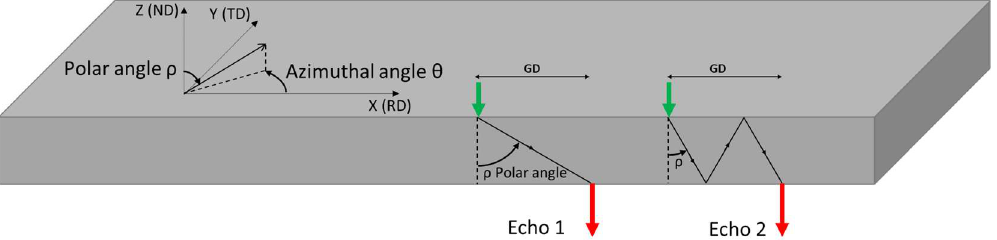
Figure 9. Illustration of how the polar angles ρ towards ND and the azimuthal θ towards RD are defined together with the measurement principle, with the green arrow representing the generation laser position and the red arrow representing the detection laser. GD is the separation between the generation and the detection lasers. For the same GD distance, different echoes will have different polar angles but the same azimuthal angle.